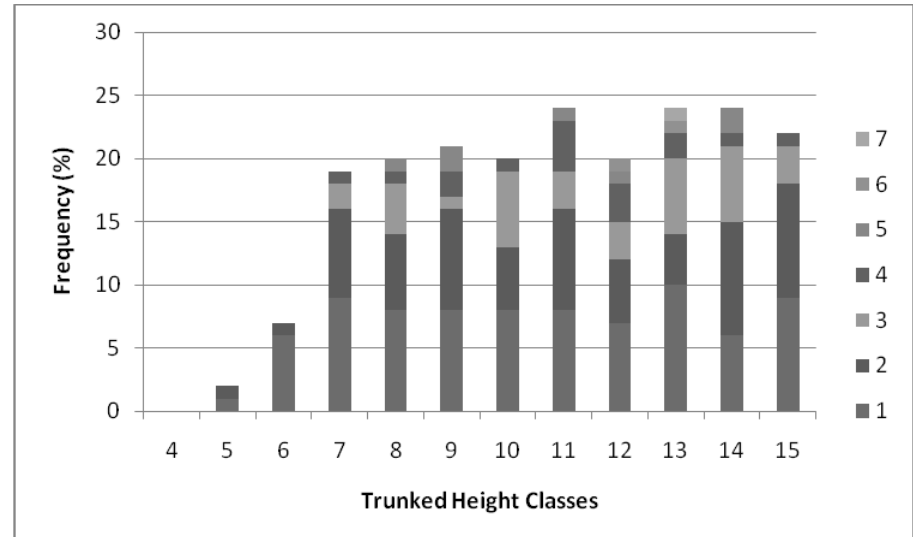
Figure 4. The percentage of H. canterburyana in each height class with each number of inflorescences present across all sites combined. Colours indicate the number of inflorescences, see legend. Height classes, 4 = trunk <0.5 m, 5 = trunk 0.5 (cid:177) 1 m, 6 = trunk 1 (cid:177) 1.5 m, 7 = trunk 1.5 (cid:177) 2 m, 8 = trunk 2 (cid:177) 2.5 m, 9 = trunk 2.5 (cid:177) 3 m, 10 = trunk 3 (cid:177) 3.5 m, 11 = trunk 3.5 (cid:177) 4 m, 12 = trunk 4 (cid:177) 4.5 m, 13 = trunk 4.5 (cid:177) 5 m, 14 = trunk 5 (cid:177) 6 m, 15 = trunk > 6